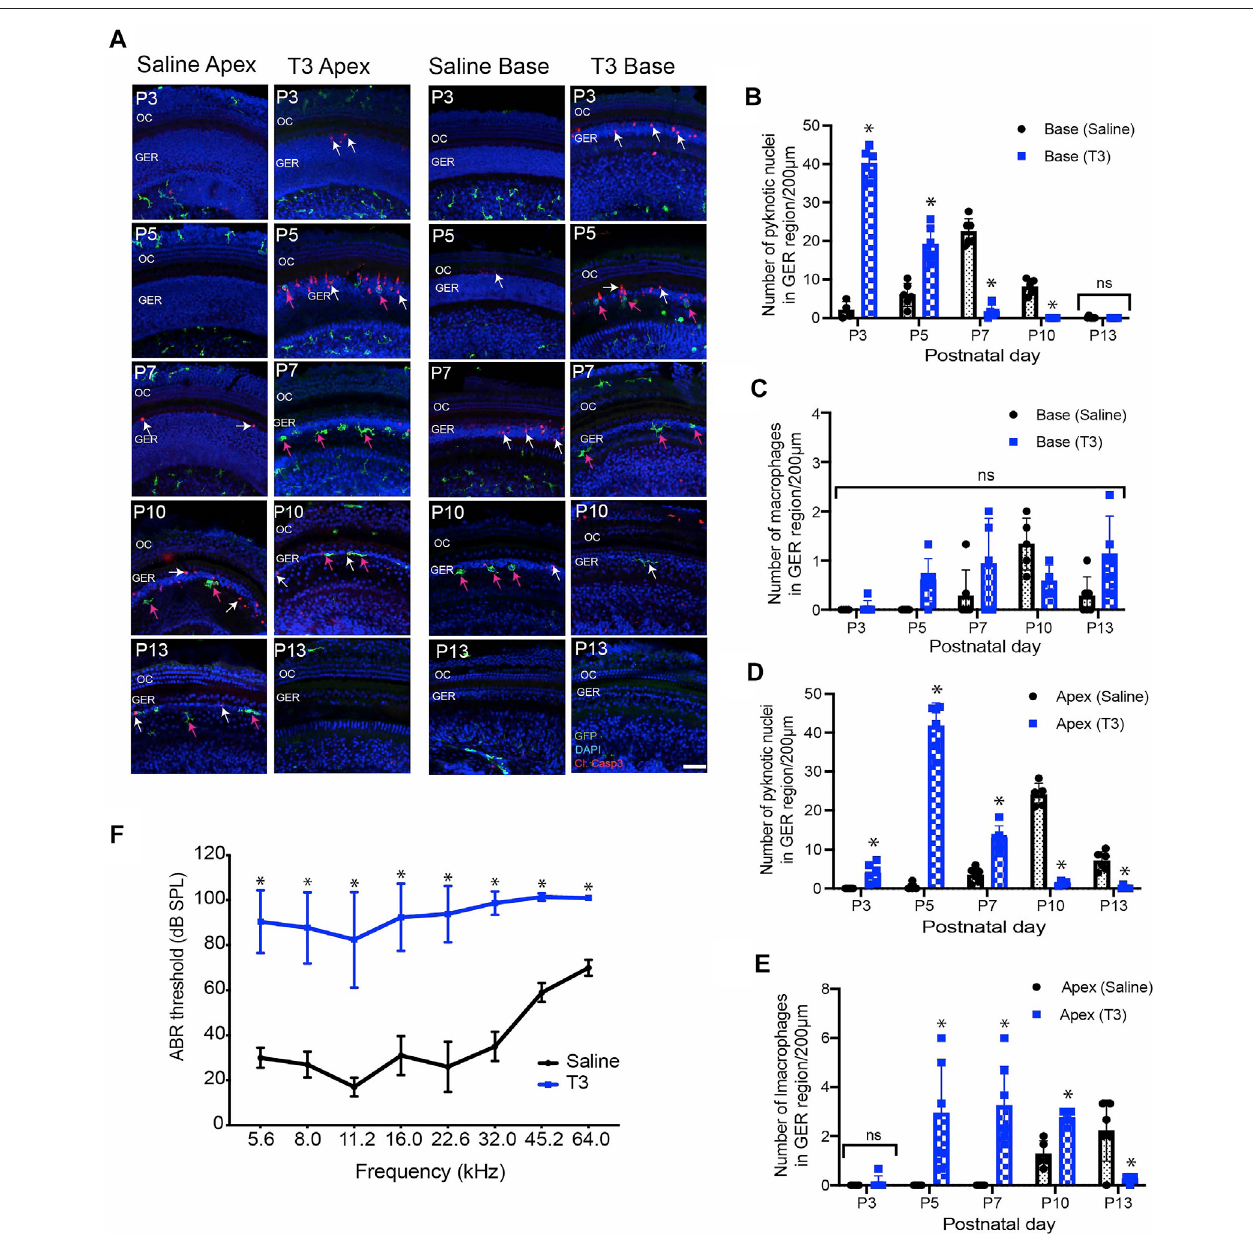
FIGURE 4 | Thyroid hormone (T3) induces early apoptosis and macrophage in fi ltration in the GER region of the developing cochlea. (A) Sensory epithelia of developing cochleae in saline-treated (control) and T3-treated CX3CR1 GFP/+ mice. Note that dying cells (white arrows) and macrophages (magenta arrows) are present ∼ 2 days earlier in mice that received T3. (B – D) Number of pyknotic nuclei in the GER region of the developing cochlea of T3 treated and control (saline) mice. (C – E) Number of macrophages in the GER region of the developing cochlea of T3-treated and control mice. (F) ABR thresholds in T3-treated and saline treated control adult mice. ABR ’ s were assessed at P30. Treatment with T3 at P0-1 led to a ∼ 60 dB elevation in ABR thresholds across the entire frequency range. Images in (A) were taken using × 20 objective lens. Labels: Red-cleaved caspase-3, Green-GFP + macrophages, Blue-DAPI. Abbreviations: OC: organ of Corti, GER: Greater Epithelial Ridge, *p: p < 0.05, relative to saline treated, ns-not signi fi cant. (N (cid:2) 3 – 6).